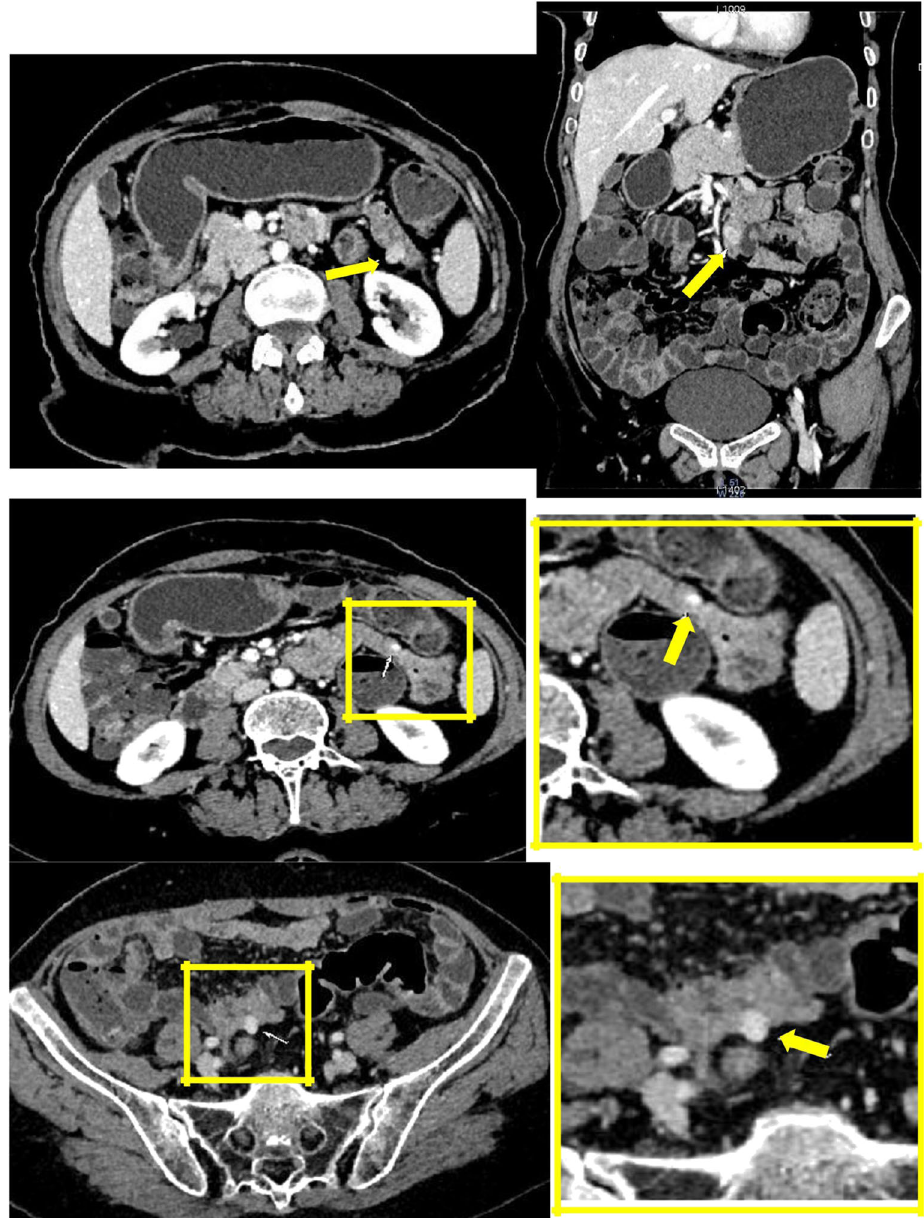
Fig. 2 A 57-year-old female with systemic NF1. Patient presented vague abdominal pain. Dual- phase contrast-enhanced CT scan reveals multiples intestinal nod- ules highly enhanced by contrast